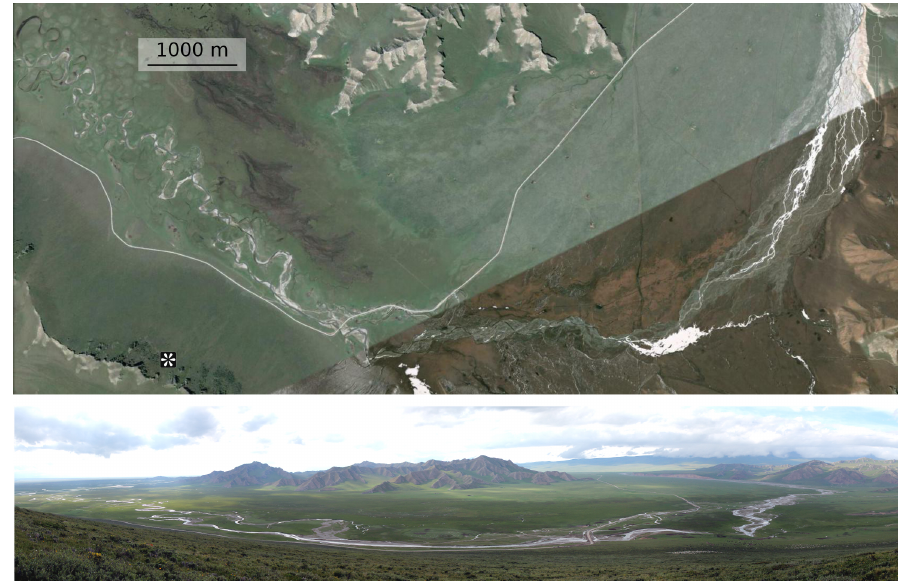
Figure 5. Satellite and panoramic view of a metamorphosis from braided to meandering (Bayanbulak Grassland, 84.578 ◦ E, 42.721 ◦ N, Google Earth). Marker on the satellite image indicates the viewpoint of the panoramic image. Its location also appears in Fig.